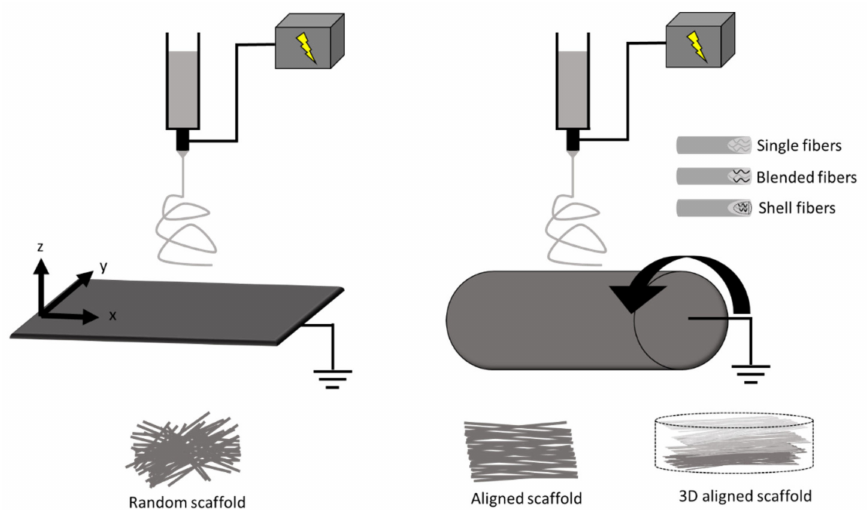
Figure 1. Schematic of electrospinning with a plane ( left ) and a cylinder ( right ) fiber collector, respectively. The movement of collectors (shown by arrows) enables the adjustment of structural properties such as fiber diameter and alignment. Other modifications in the fabrication include blended and core / shell electrospinning to include a hybrid of materials to control the sca ff old properties. Sca ff olds can also be functionalized, stimulated, or constructed into 3D